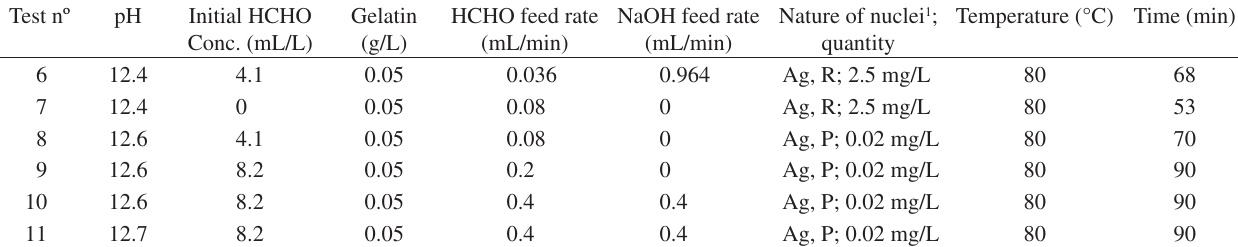
Table 1. Experimental conditions. B) Fed-batch